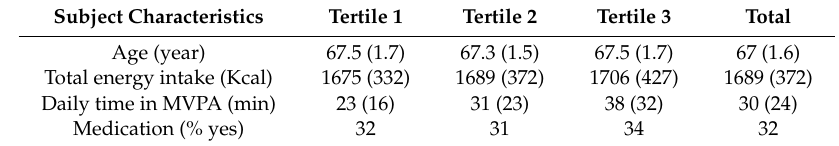
Table 1. Subject characteristics in the study sample and across tertiles of DASH-adherence.